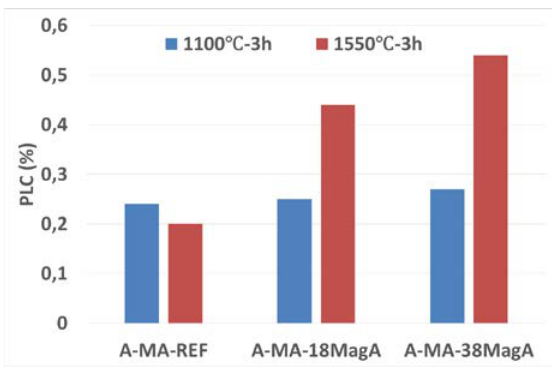
Figure 3. Cold modulus of rupture (CMOR) after curing at 20 °C and after heat treatment ( a ) and hot modulus of rupture (HMOR) at 1450 °C ( b ).